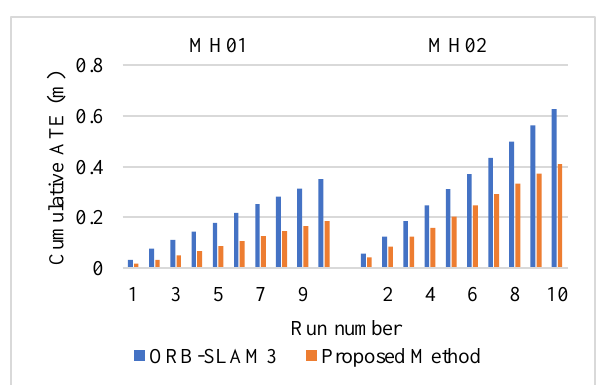
Figure 5. Cumulative ATE results in mono-inertial mode.